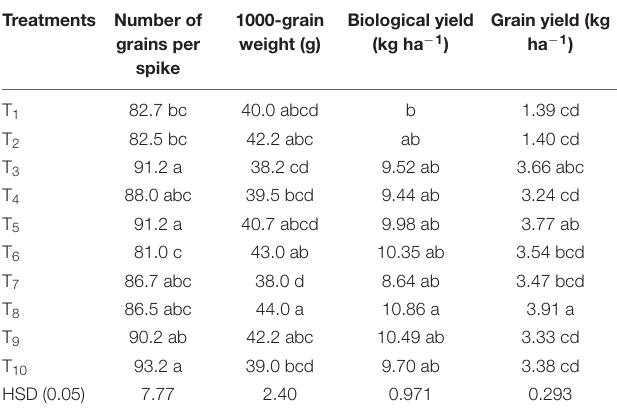
TABLE 2 | Influence of metribuzin alone and with adjuvants on a number of grains per spike, 1,000-grain weight (g), biological yield (kg ha − 1 ), and grain yield (kg ha − 1 ) of wheat (average of 2 years’